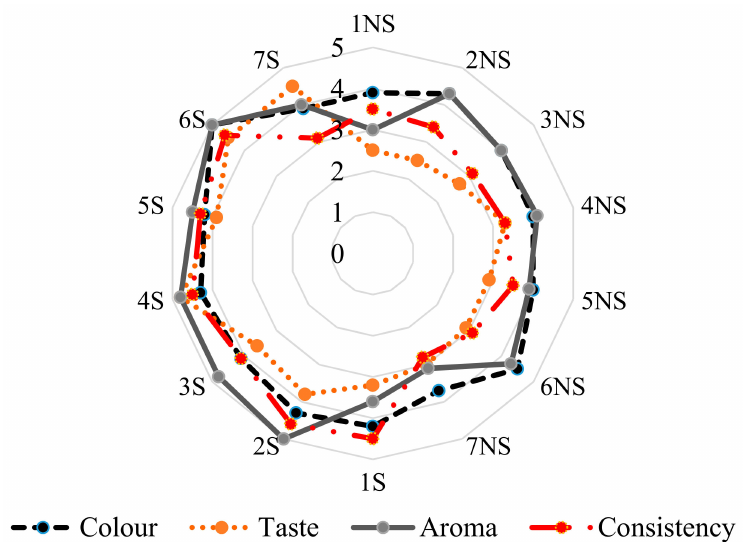
Figure 2. Sensory evaluation in red apple ciders before and after storage. NS, after fermentation;